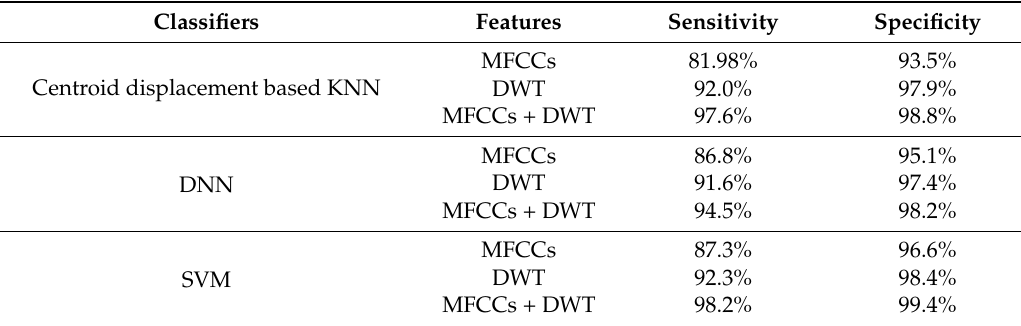
Table 6. Sensitivity and Specificity calculated for each classifier performance based on the Figure 6 confusion